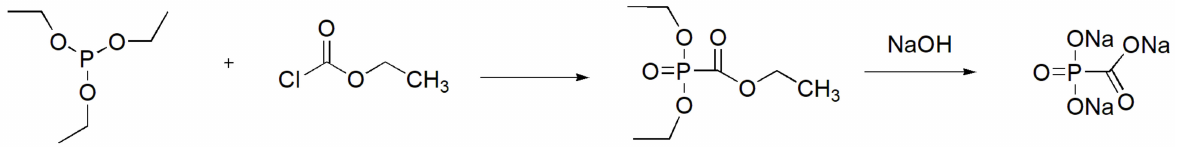
Figure 3. Cytotoxicity of triphenylmethylphosphonates against two human malignant melanoma cell